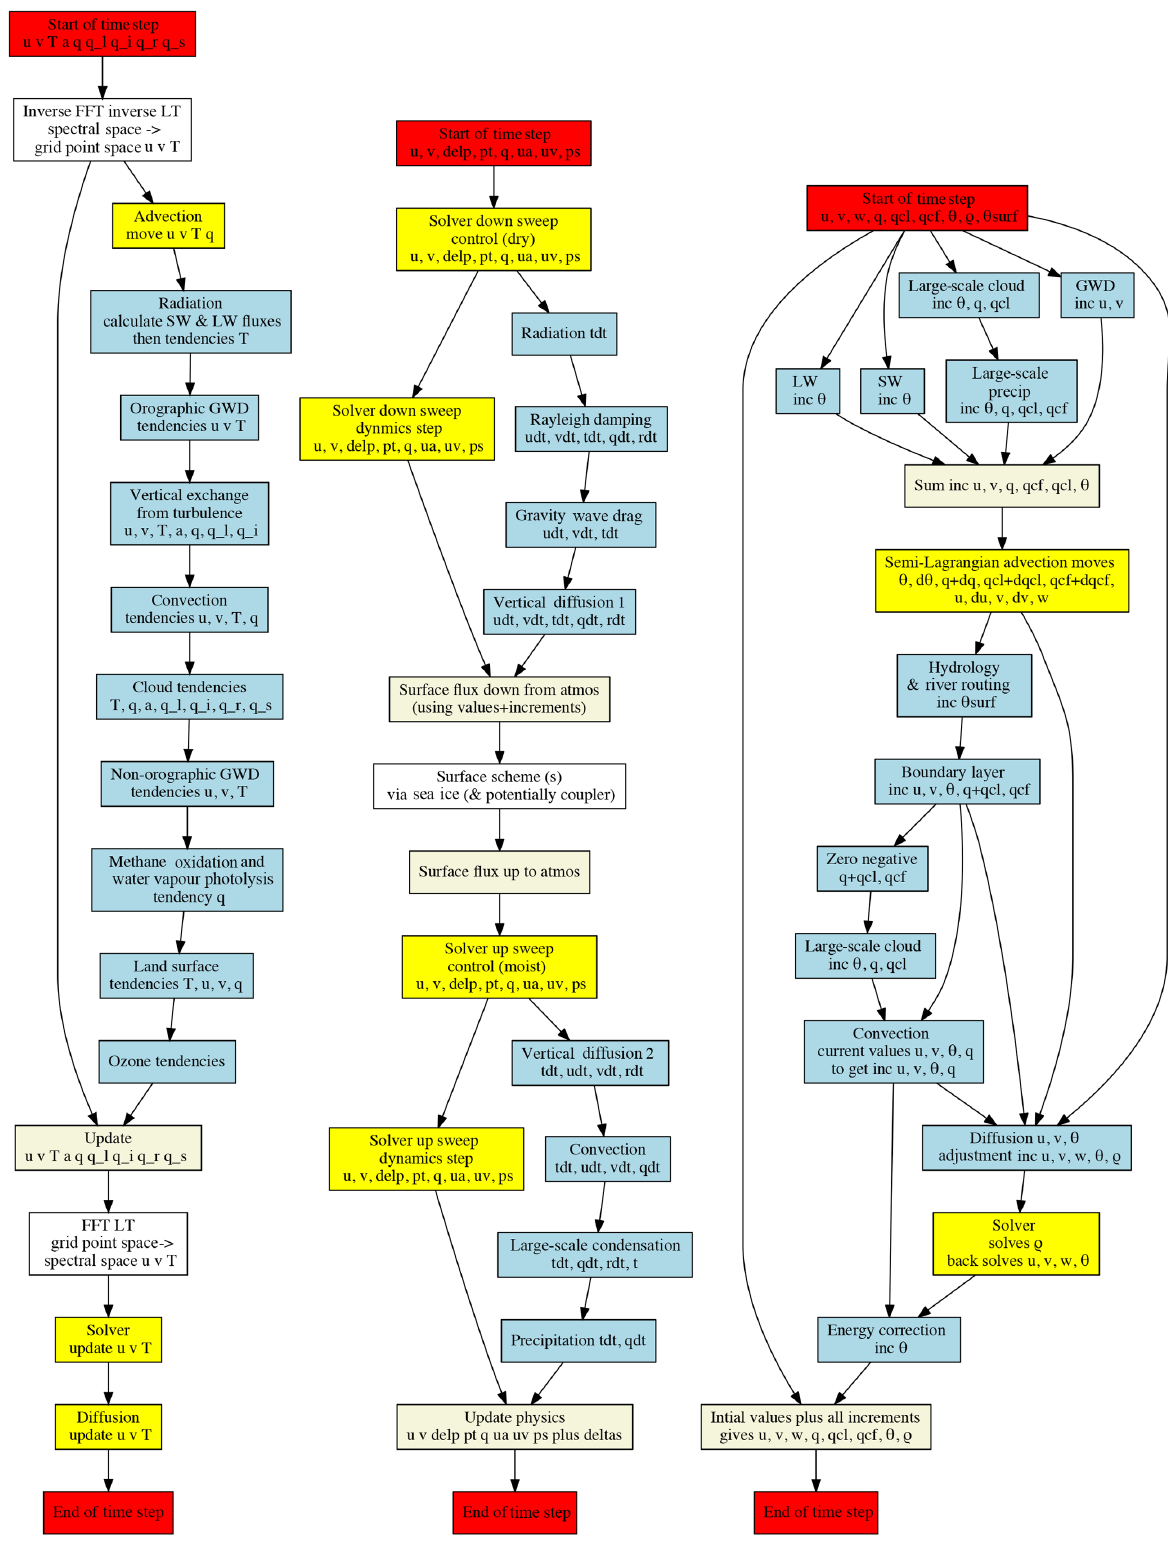
Figure 3. A programmer view of data flow and the interaction of dynamics and physics in the atmosphere of three prominent models: ECMWF IFS, GFDL HIRAM, and the Met Office UM. Red boxes show the start and finish of time steps, yellow boxes show dynamics, blue boxes increment physics, beige boxes physics with full values, and external coupling or library routines are shown in the white boxes. Not all prognostic variables and associated routines are